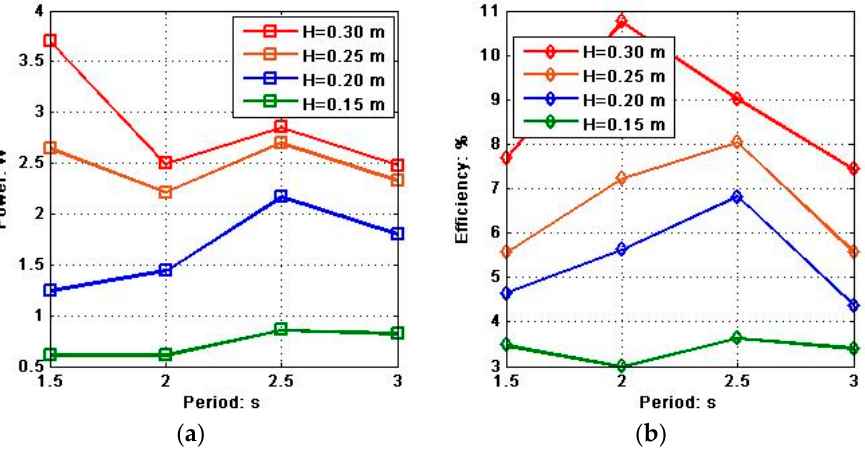
Figure 22. Generation performance of the ACWEC with different average wave periods, M 1 = 20.11 kg: ( a ) power curve; ( b ) efficiency curve.